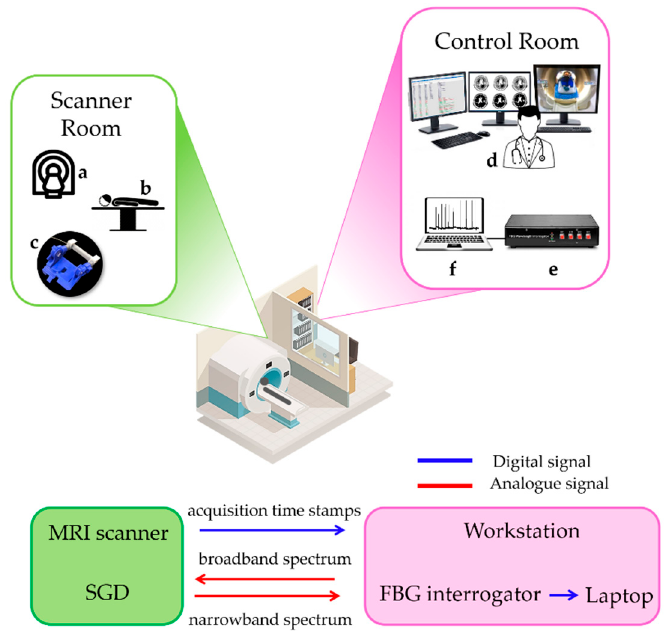
Figure 9. Experimental set-up of fMRI trial with the data flow: the MRI scanner ( a ), the patient ( b ), and the robotic interface instrumented by the SGD ( c ) in the scanner room, and the workstation ( d ), the FBG interrogator ( e ), and the laptop ( f ) in the control room. Digital and analogue data flows between the scanner and control rooms are shown using blue and red arrows, respectively.